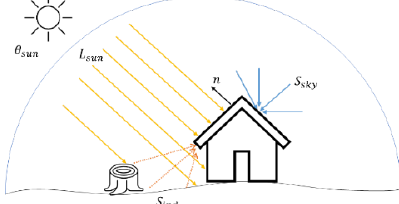
Figure 1. The outdoor illumination model (Yellow arrows are sun illumination; blue arrows are sky illumination; red arrows are reflected indirect